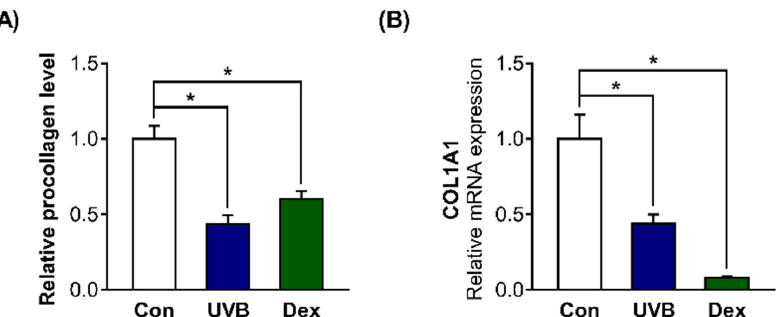
Figure 2. Inhibitory effects of UVB radiation or Dex on collagen synthesis in Hs68 cells. The cells were treated with or without 20 mJ/cm 2 UVB or 1 µ M Dex. ( A ) After treatment for 24 h, the relative amount of type-1 procollagen was measured in the culture supernatants using enzyme-